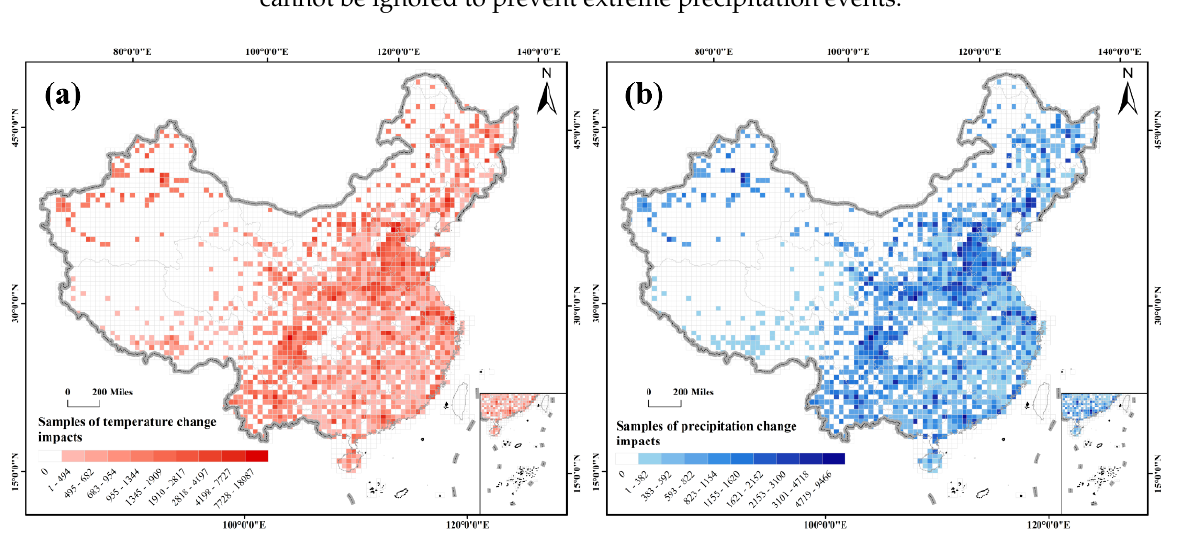
Figure 5. Maps of the impacts of changes in temperature and precipitation. ( a ) Map of the impact of changes in temperature. ( b ) Map of the impact of changes in precipitation.